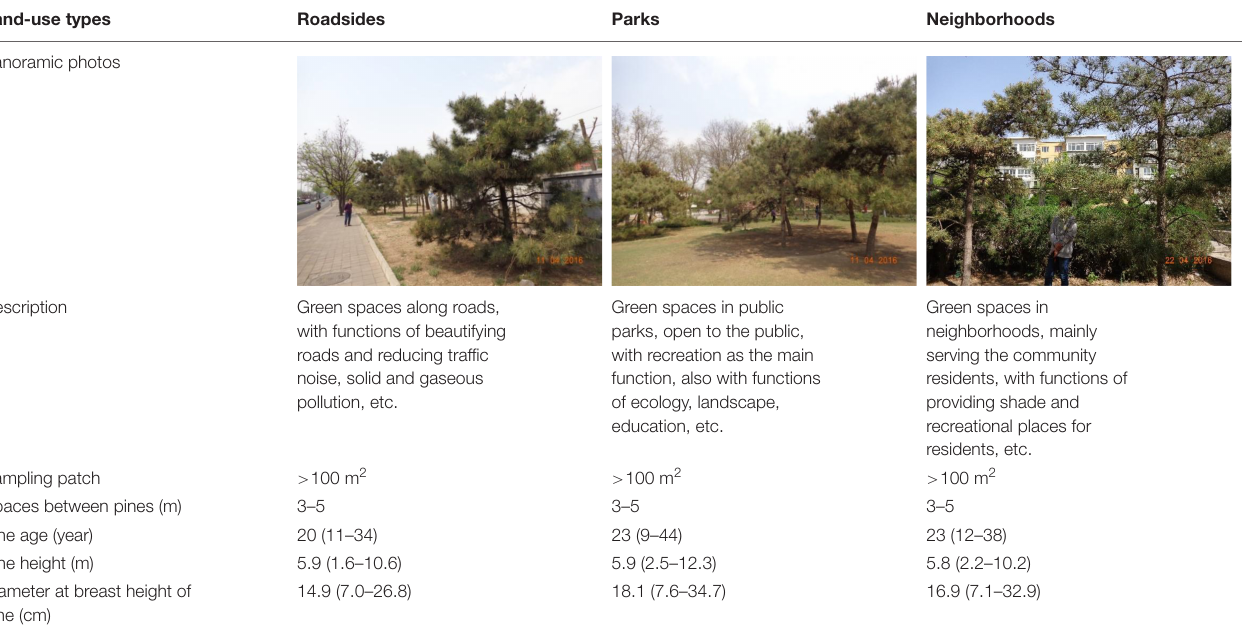
TABLE 2 | Definition and characteristics for each land-use